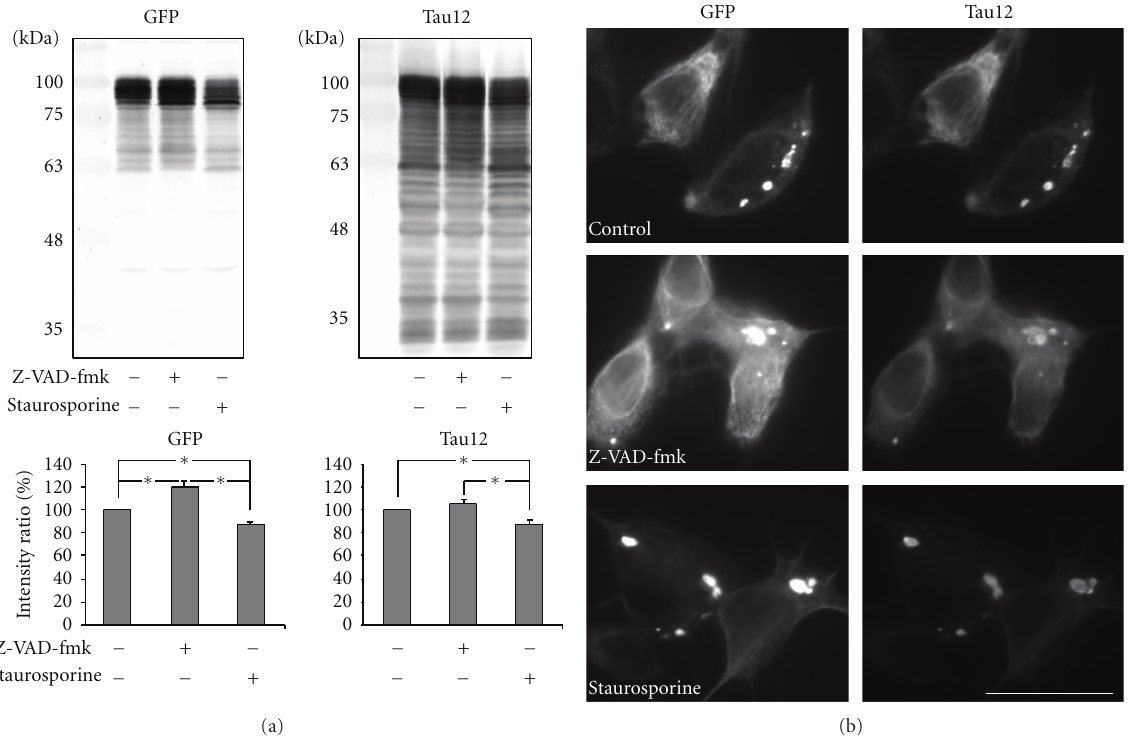
Figure 4: Validity of GFP as an N-terminal marker of tau. (a) presents representative immunoblots of lysates from cell expressing GFP-3PO without any treatment and with treatment of either staurosporine or Z-VAD-fmk as indicated. Blots were probed with anti-GFP or Tau12 (aa9–18) to show N-terminal truncation of tau upon pharmacological manipulation of caspase activity. Migration of molecular weight standards is indicated on the left of each blot. Note the absence of anti-GFP specific band(s) absent in Tau12 blots. The accompanying graphs presents the mean intensities ( ± SEM) derived from 3 immunoblots. The relative intensities of the uppermost bands from anti-GFP and Tau12 were normalized to that of their respective untreated controls. Staurosporine decreased tau levels in both GFP and T12 blots. Z-VAD-fmk statistically increased tau levels as indicated by anti-GFP and displayed a trend towards significance by Tau 12 ( P = 0 . 062, Student t -test). An asterisk indicates a statistical di ff erence ( P < 0 . 05; Student’s t -test). (b) presents double immunofluorescent staining of cells untreated or treated with either Z-VAD-fmk or staurosporine as indicated. The bar represents 20 μ m. Note the identical colocalization pattern between anti-GFP and Tau12 stainings regardless of pharmacological manipulation of caspase